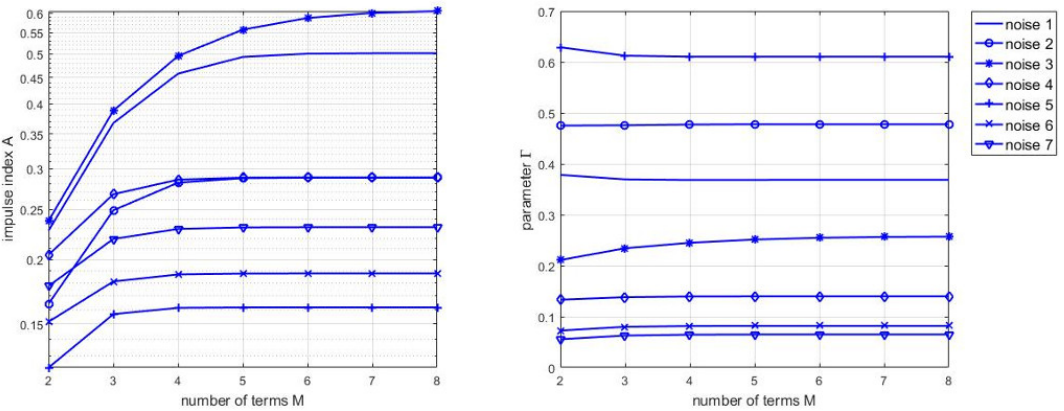
Figure 9. A and Γ versus the number of terms M for noise measured in